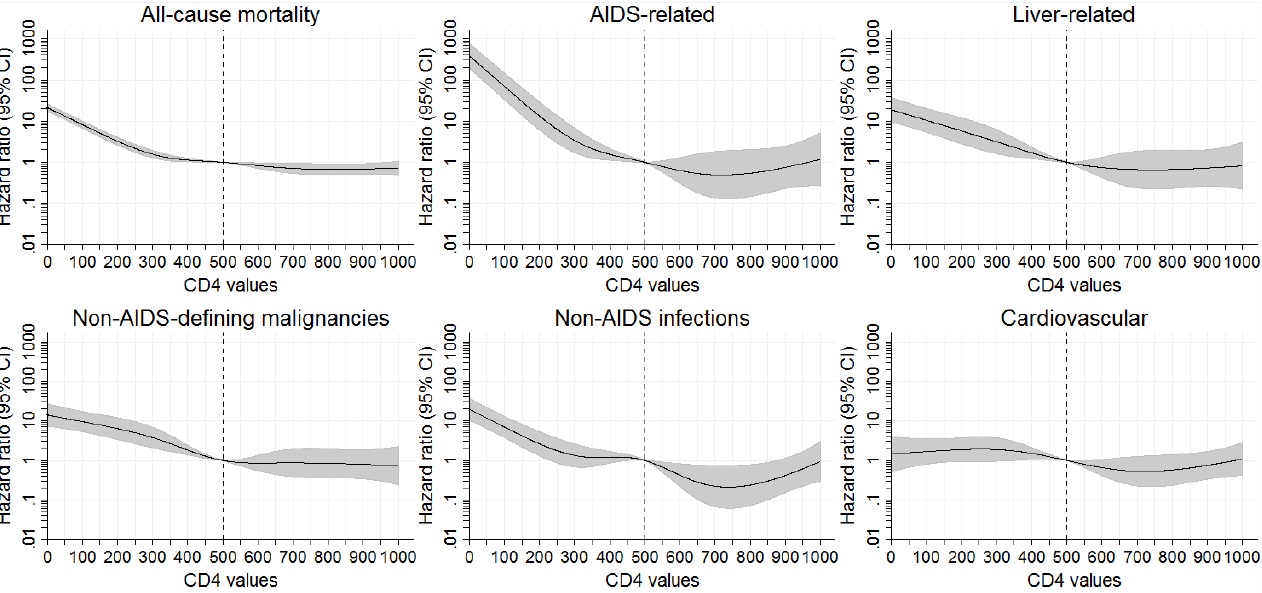
Figure 1. Associations of latest CD4 counts with all-cause mortality and specific causes of death. Results from adjusted Cox regression models including all time periods.